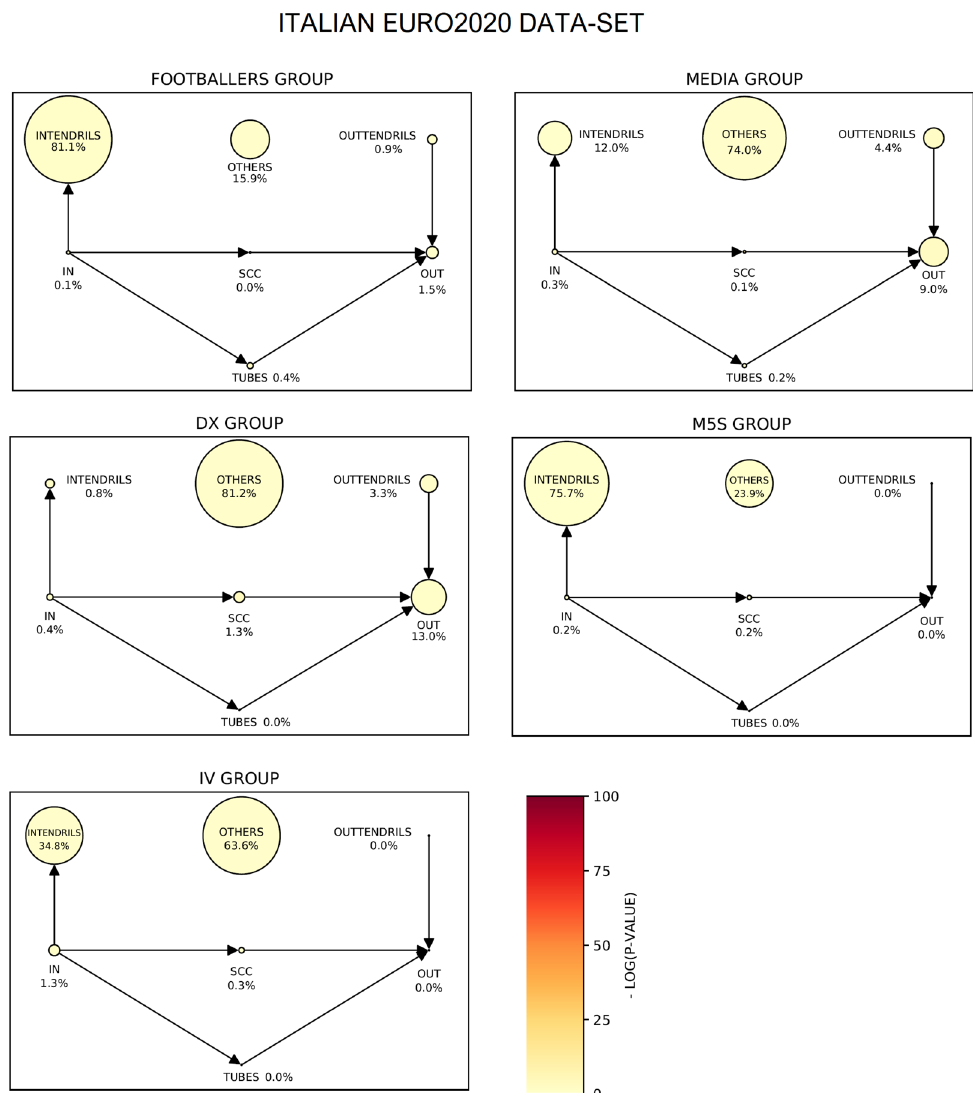
Figure 9. The bow-tie structure of the discursive communities for the Italian EURO2020 dataset. The dimension of the sectors is proportional to the number of nodes therein and the color quantifies the distance between the observed and the predicted dimension. The main discursive community is formed by football players, sports newspapers and journalists. Then, we identified a MEDIA community, containing accounts of Italian media, and three small political communities (DX, IV, M5S). MEDIA, DX and IV do not display an informative bow-tie structure (respectively 74%, 81.2% and 63.6% of the nodes in OTHERS), while FOOTBALLERS and M5S show a weak bow-tie (respectively 81.1% and 75.7% of nodes in